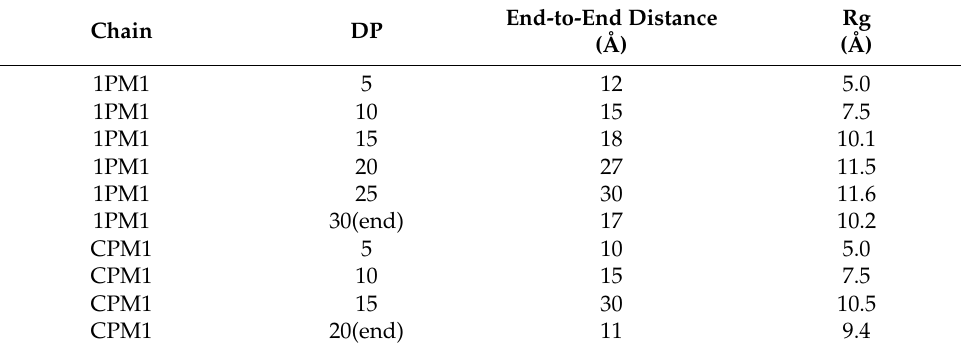
Figure 5. ( a ) Molecular conformation evolution of 1-pentene–maleic anhydride (1PM) during the growth process in the nonpolar solvent. The green atom is the active center, and polydispersity index (DP) is 5, 10, 20, and 30 from left to right, respectively; ( b ) the molecular conformation evolution of cyclopentene–maleic anhydride (CPM) during the growth process. DP is 5, 10, 15, and 20 from left to right, respectively. Table 1. Molecular size parameters during polymerization